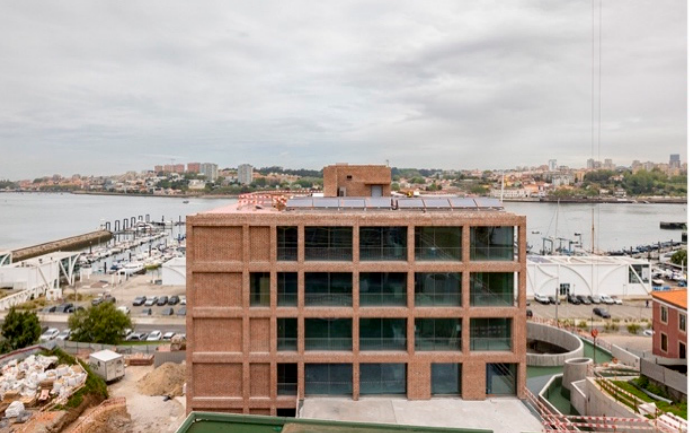
Figure 30. Vila Nova de Gaia. ©João Ferrand.